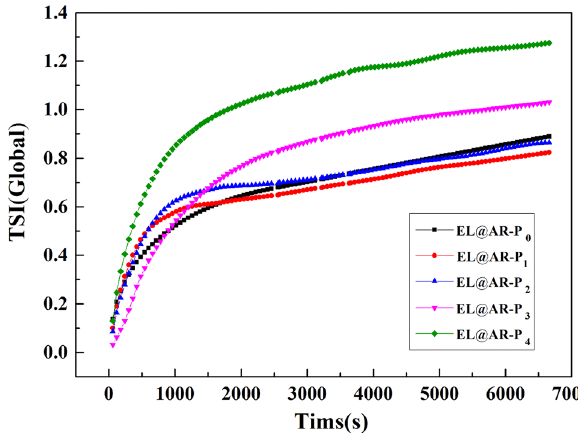
Figure 4: Stability of EL@AR - P